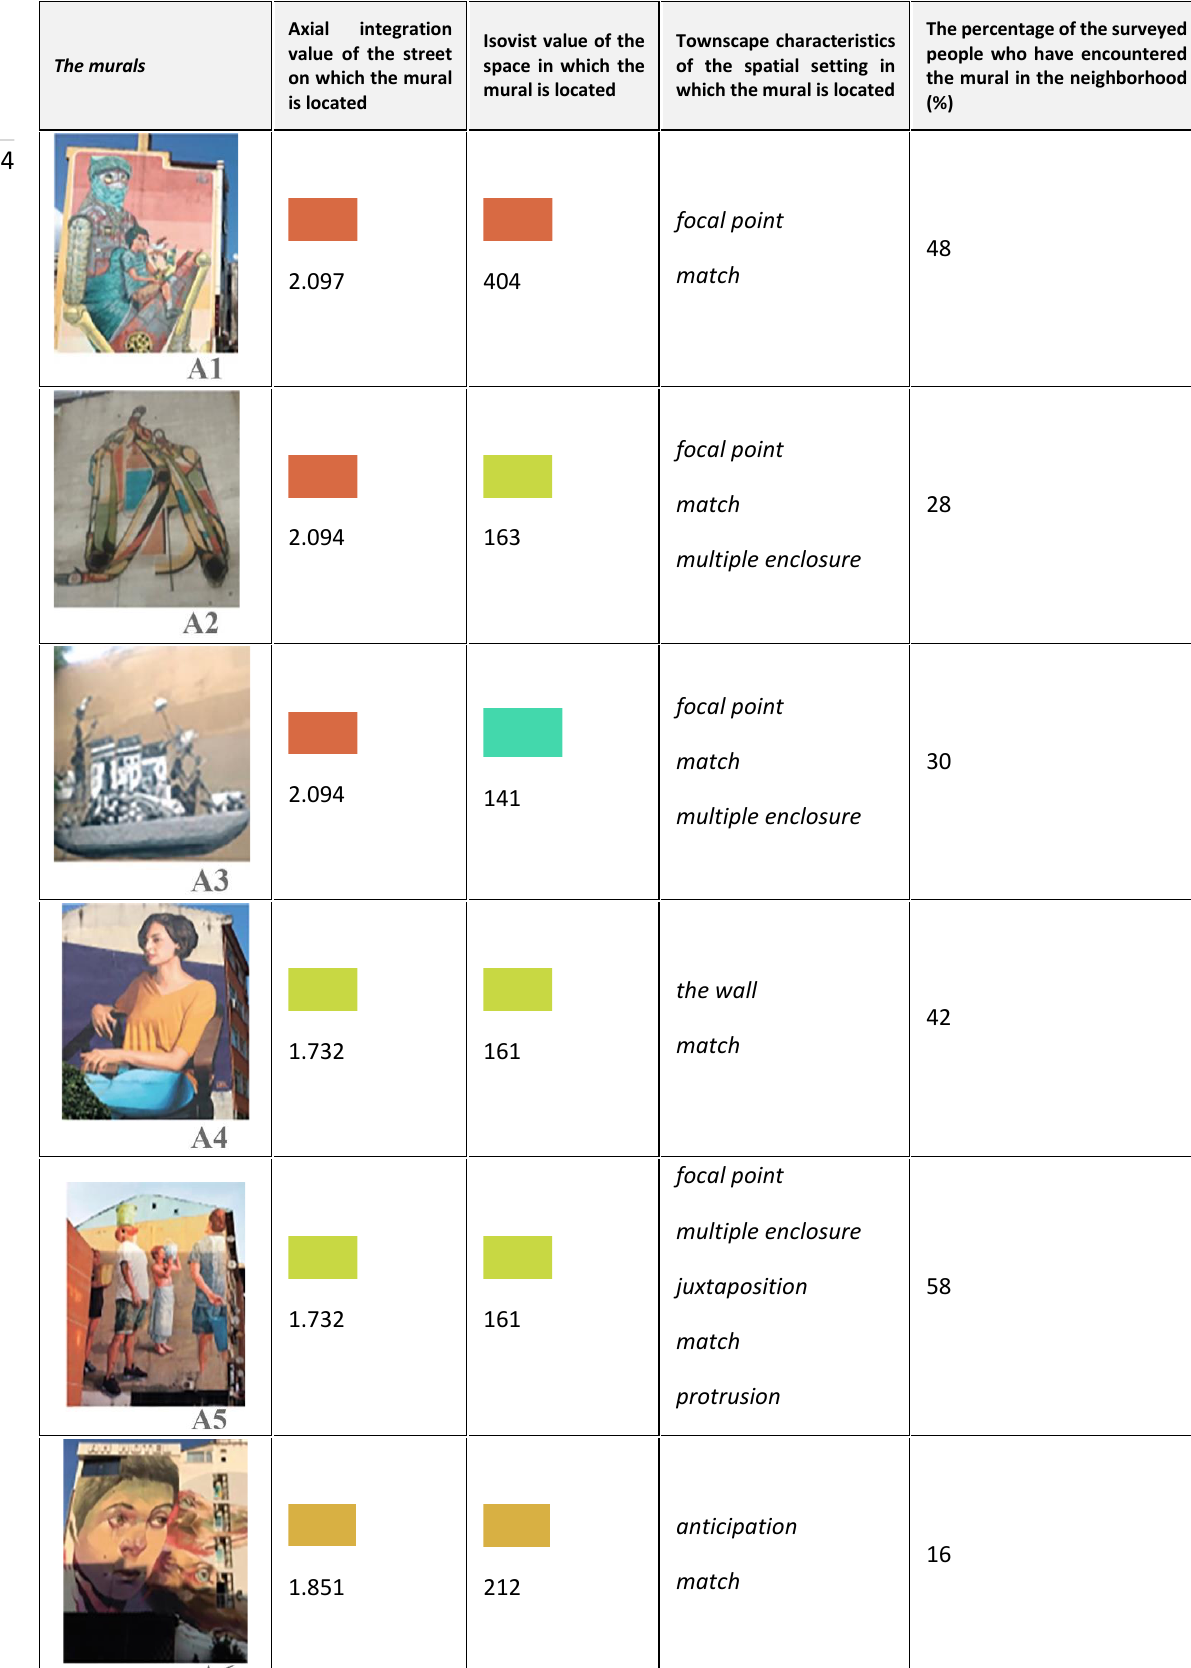
Table 1 The matrix showing the results of the spatial analyses and the survey results.